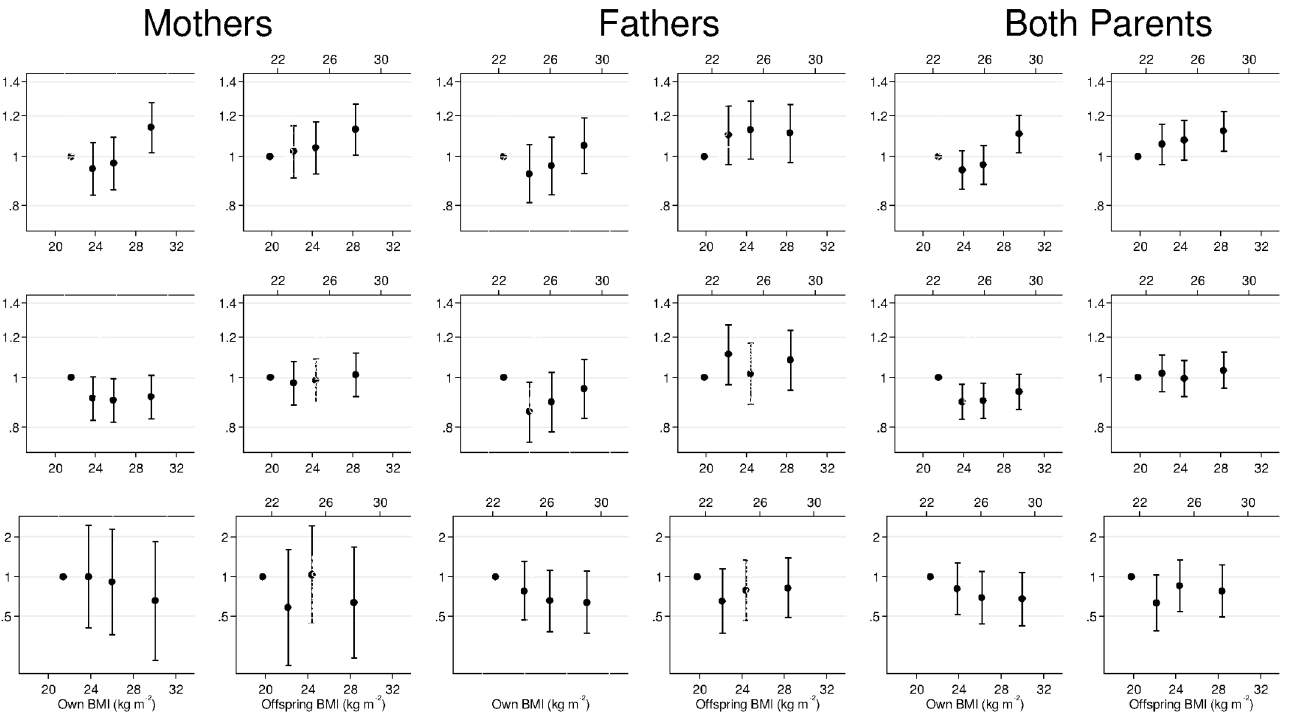
Fig 2. Odds ratios (OR) for depression and anxiety, and hazard ratios (HR) for suicide mortality, by quartiles of own and offspring body mass index relative to the smallest quartile. Body mass index was pre-adjusted for age and HUNT wave and converted to sex-specific Z scores before classification into quartiles. It is plotted as the mean body mass index for each quartile, converted back to kg m -2 for men (upper X-axis) and women (lower X-axis). All models were adjusted for parental age, date of birth and education. Note the different scale on the y-axis for